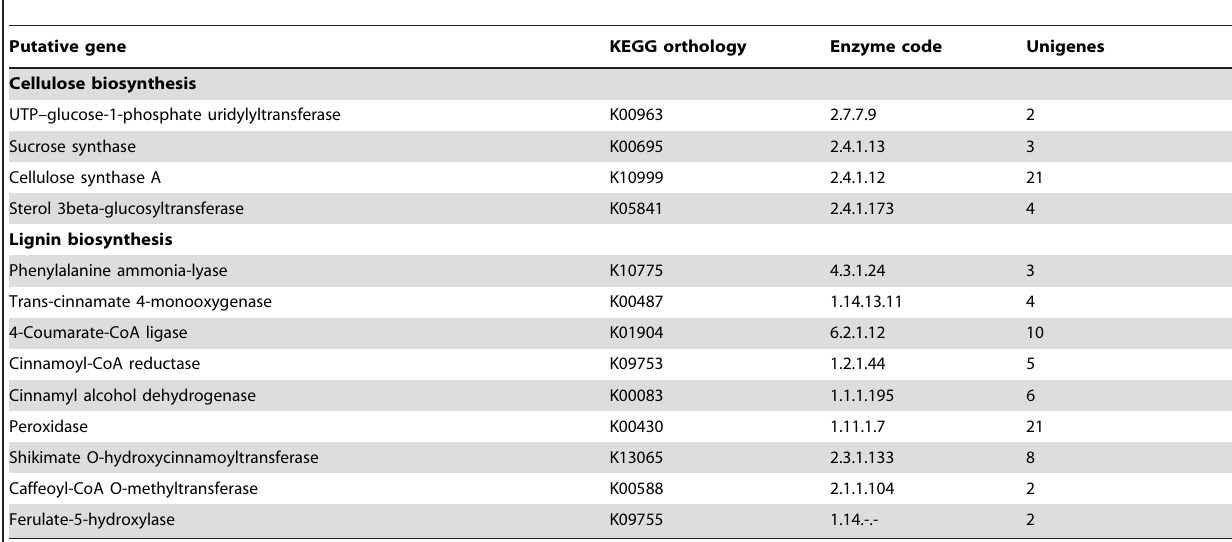
Table 5. List of genes comprising the cellulose and lignin pathways found among P. maximum unigenes.